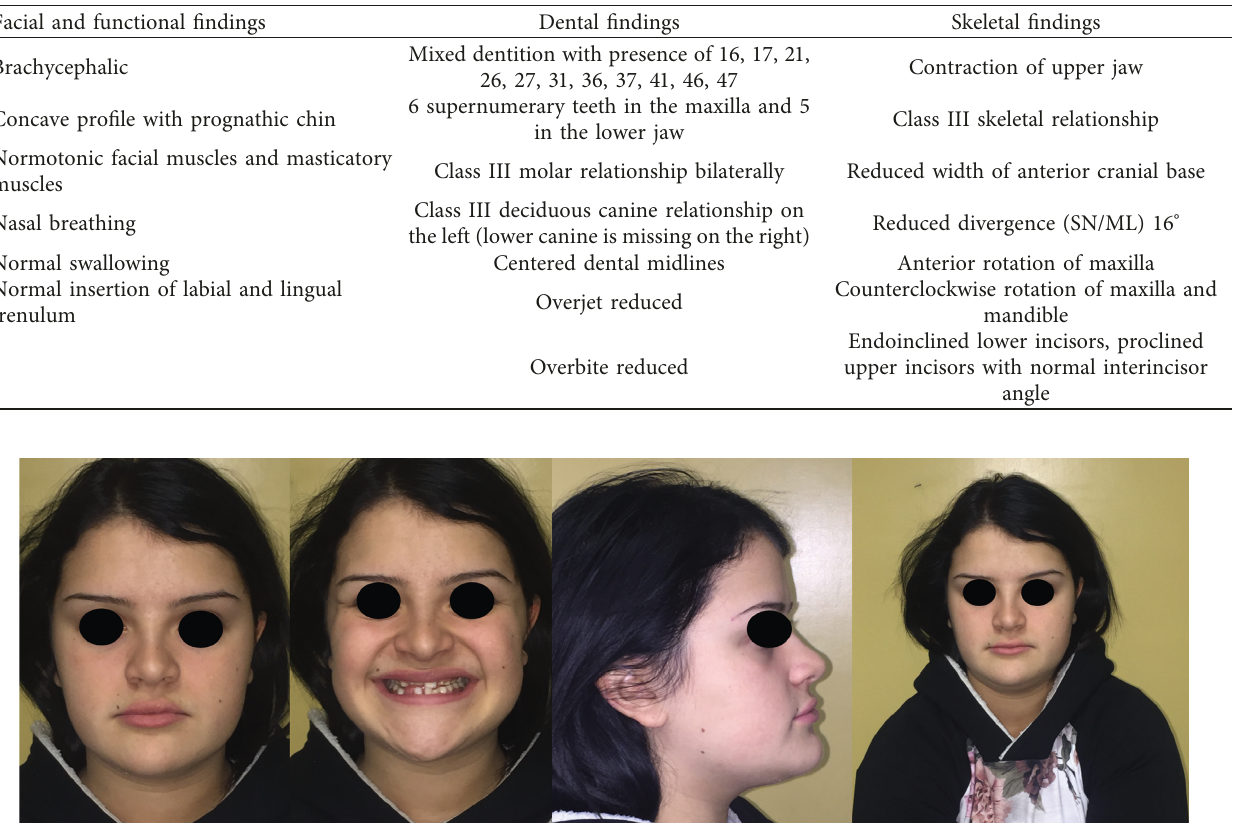
Table 12: Case 2: orthodontic diagnosis summary.